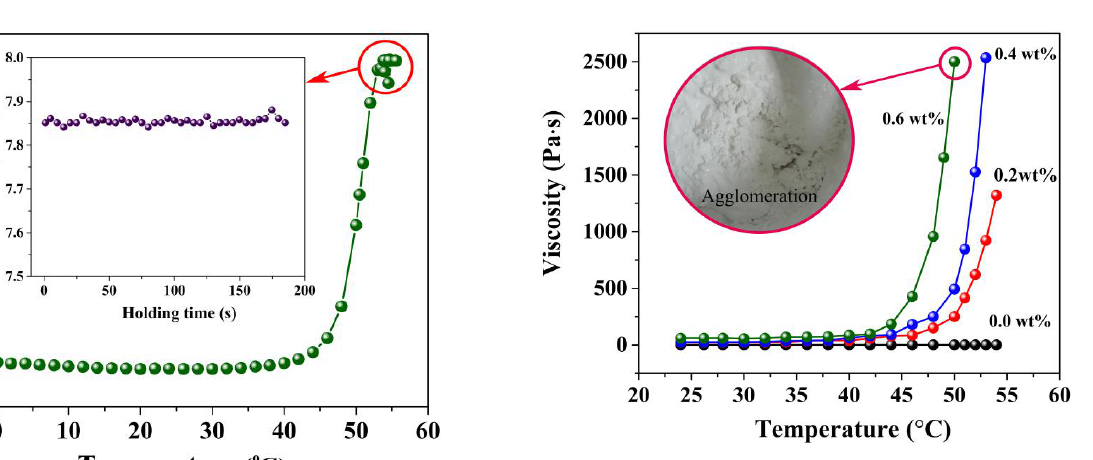
Fig. 5 Solidification properties of alumina slurries with different carrageenan concentrations on heating (solid loading of 56